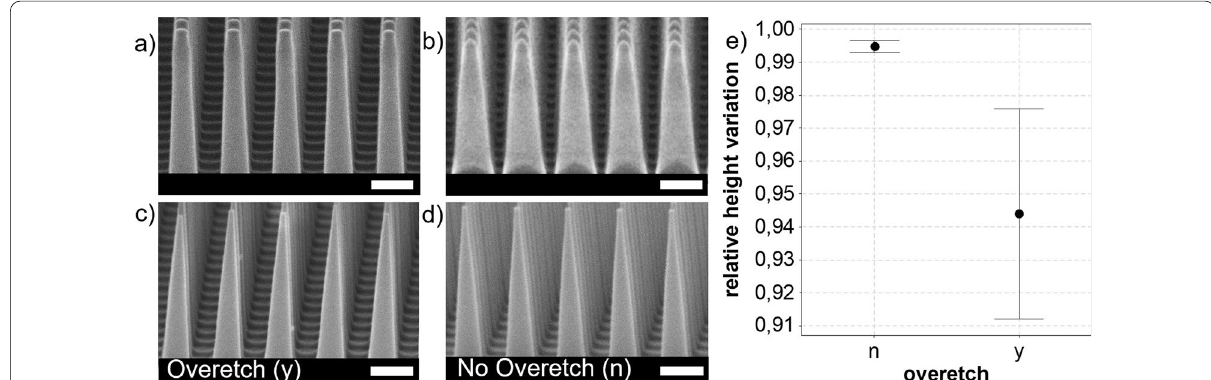
Fig. 2 Cross-sectional images collected by SEM, after CM-ICP RIE of silicon in an argon plasma, a (1 min etching) and b (20 min etching), and after rat-IBE of the SiNWs, c (overetch (y)) and d (overetch (n)). The scale bars represent 200 nm. The relative height variation in the case of an overetch ( y ) or no overetch ( n ) is quantified in e where the interval plot is based on a 95% CI with N =